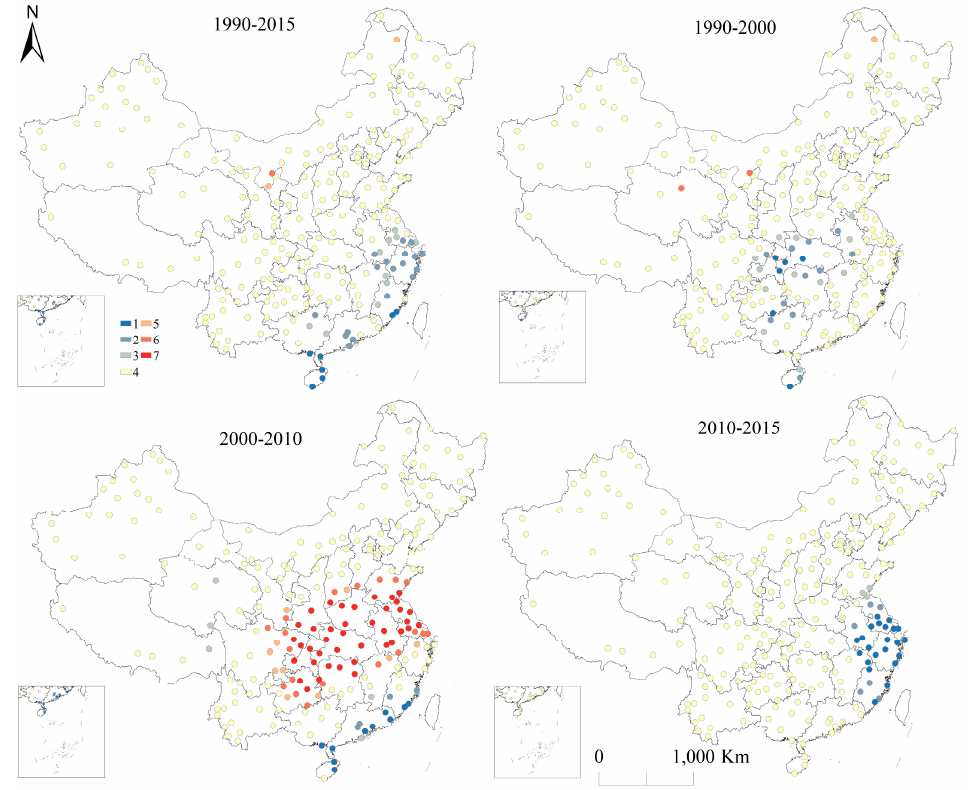
Figure 5. High–low-value aggregation of AEZs’ ESV change from 1990 to 2015 (1, cold spot with 99% confidence; 2, cold spot with 95% confidence; 3, cold spot with 90% confidence; 4, not significant; 5, hot spot with 90% confidence; 6, hot spot with 95% confidence; 7, hot spot with 99% confi- dence).